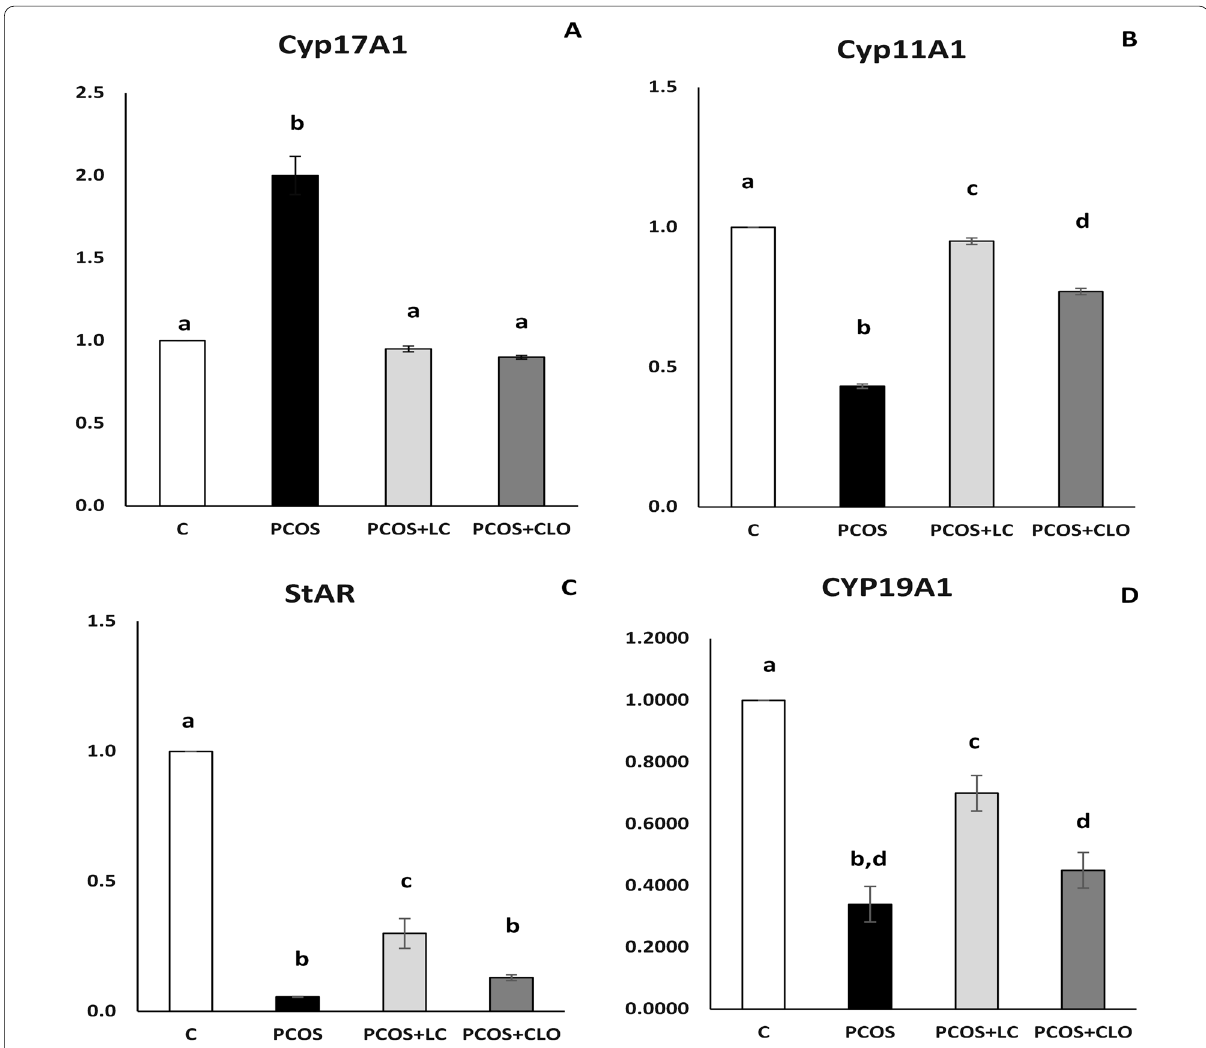
Fig. 3 Effect of l -Carnitine and Clomiphene citrate on mRNA relative gene expression of Cyp17a1, Cyp11a1 and STAR genes in ovarian tissue of different groups in letrozole-induced PCOS rat models. A CYP17A: Cytochrome P450 17 A1, B CYP11A1: Cytochrome P450 11 A1, C StAR: Steroidogenic Acute Regulatory protein, D CYP19A1: Aromatase in different groups. Values presented as mean different superscript letter are statistically significant at P < 0.05. C: Control group, PCOS: letrozole induced polycystic ovarian syndrome, PCOS letrozole induced polycystic ovarian syndrome treated with l -Carnitine, PCOS Clomiphene